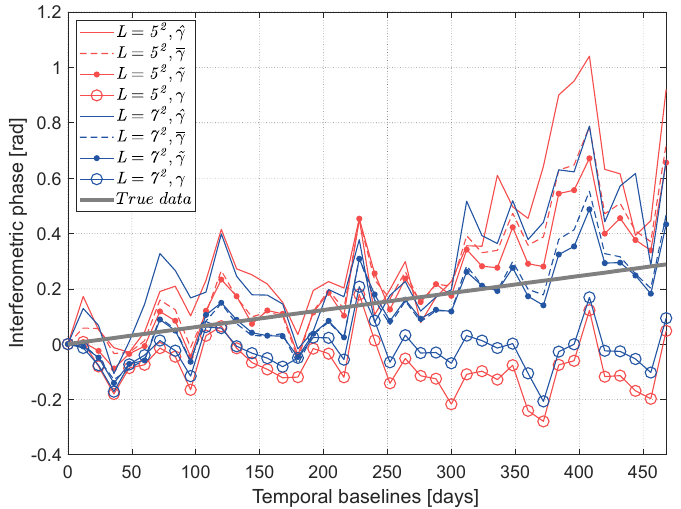
Figure 9. Reconstructed phase series of a single point using different coherence magnitude estimators.